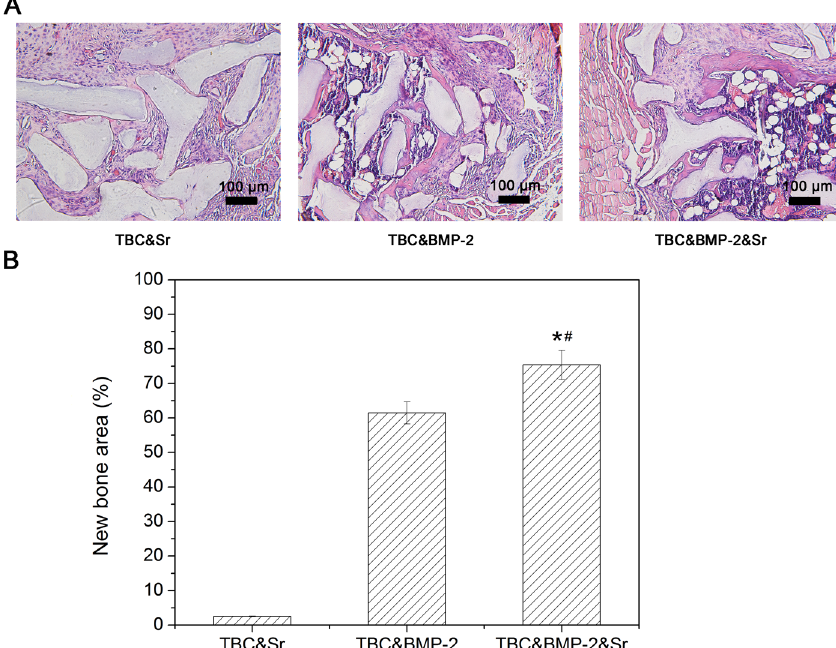
Fig. 2 A Four weeks after the operation, the histology of each group was observed (HE staining, ×200); B Quantitative area of new bone formation ( n = 3); compared with TBC&Sr, * p < 0.05; compared